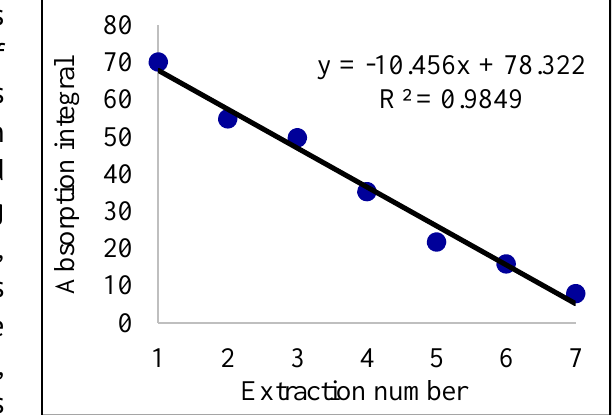
Figure 5. Linear model of light absorption